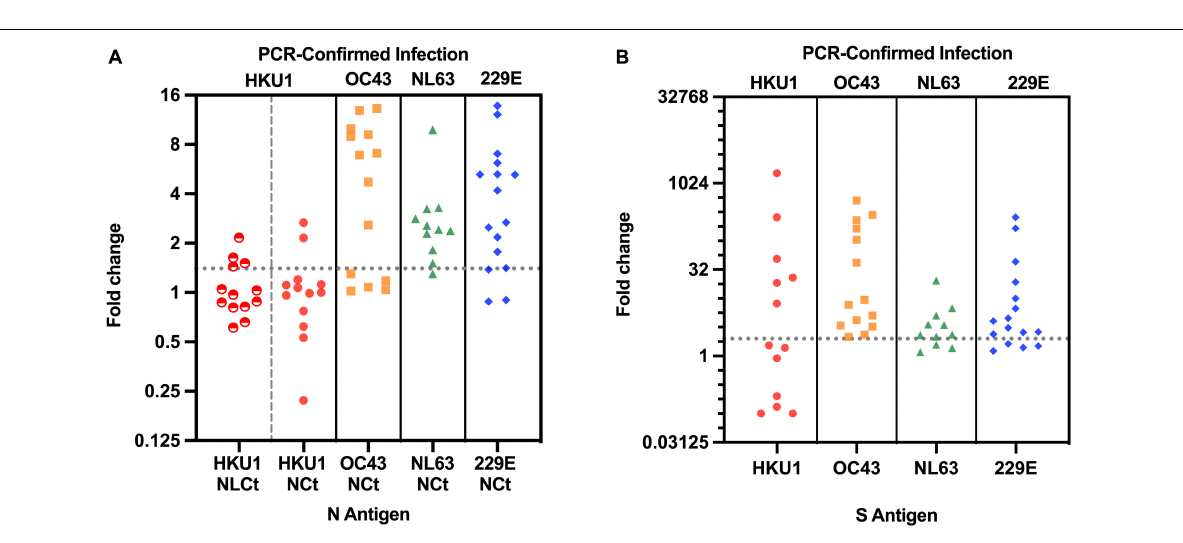
FIGURE 2 | (A) V1-V2 Fold change in antibody values of 54 subjects with PCR-confirmed endemic HCoV infection, as assayed with ELISA with matched N antigen. For HCoV-HKU1-infections, both HKU1-NLCt (half-filled red circles) and HKU1-NCt (full red circles) were used for the N assay. Dotted line represents cutoff of significant antibody rise (fold change of 1.40 or higher). The NCt ELISA fold change values for all four endemic coronaviruses have been published previously Edridge et al. (2020). (B) V1-V2 Fold change in antibody values using matched S antigens for each HCoV infection in the S-Luminex assay. Dotted line represents the cutoff of significant S-antibody rise (fold change of 2.01 or